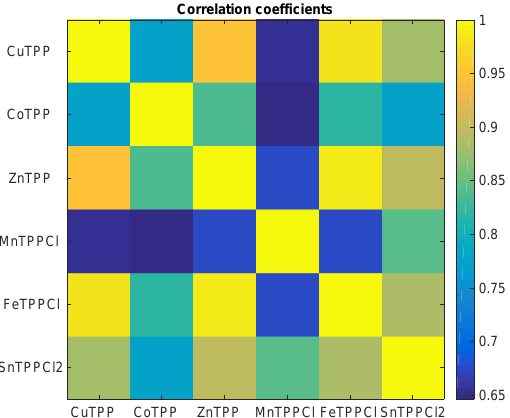
Figure 4. Map of linear correlations of sensors data. The magnitude of correlation is given in a color